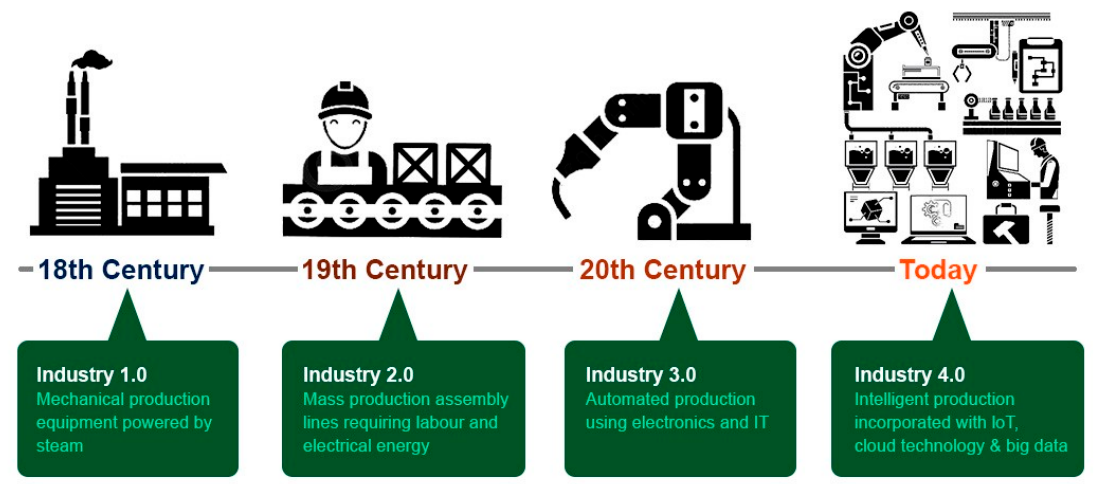
Figure 1. The four industrial revolutions.